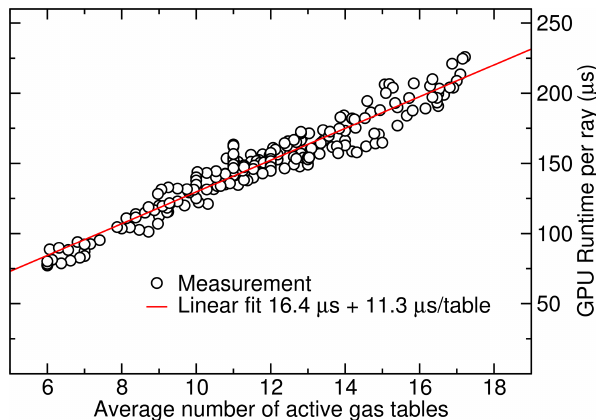
Figure 8. Spectral coverage of 24 selected gases between 650 and 2450cm − 1 . In addition to these gases, CO 2 , H 2 O, and NH 3 are considered over the entire spectrum. The total number of active gases varies between 6 and 18 as shown by the stair-type line.